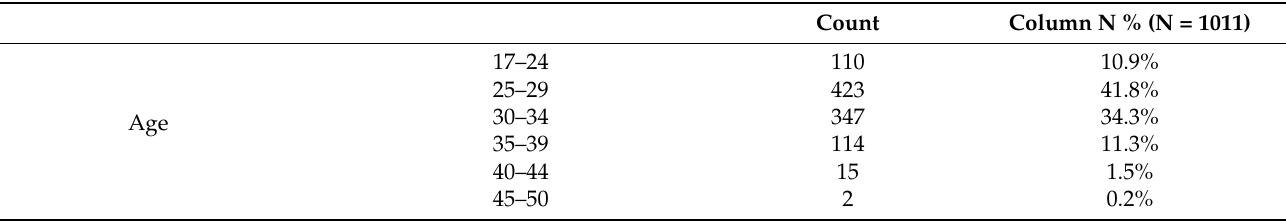
Table 1. Characteristics of the studied